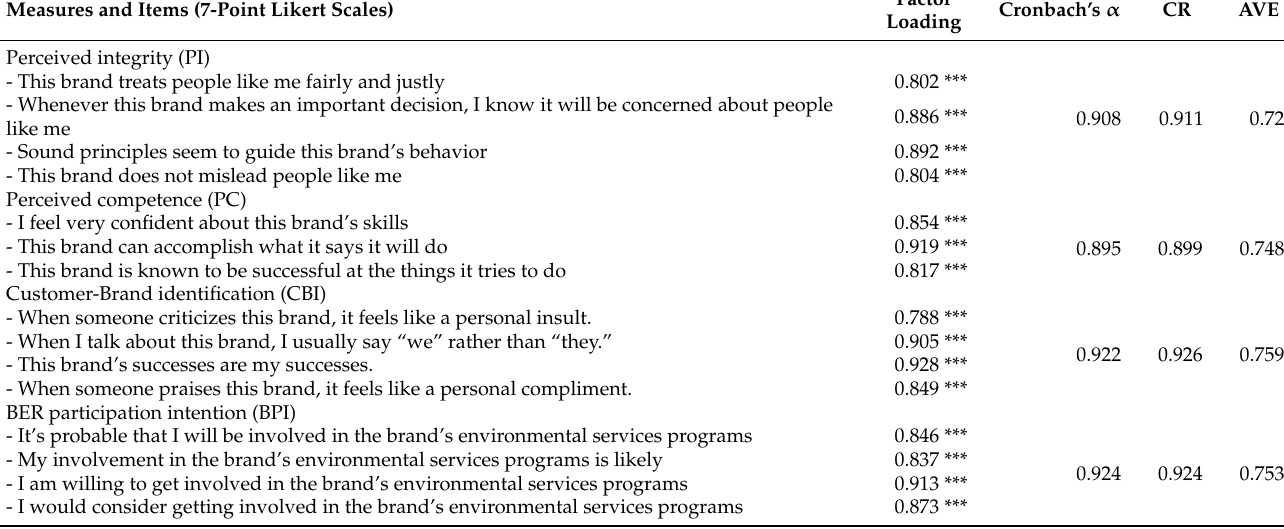
Table 1. Reliability of Constructs.